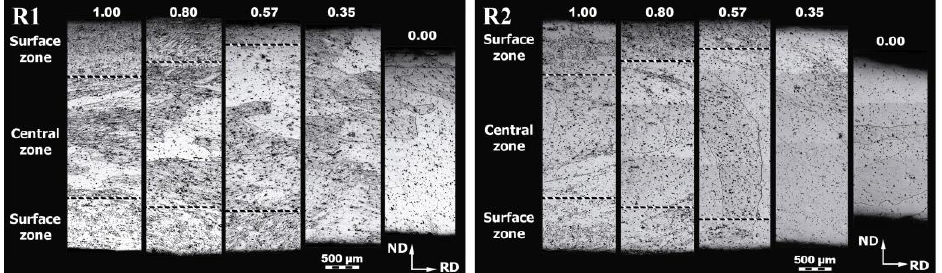
Figure 7. Optical macrographs for each rolled step in the transversal section of R1 and R2 samples. The numbers indicate the ε values. Dotted lines delimit the surface and central zones where the grain changes.